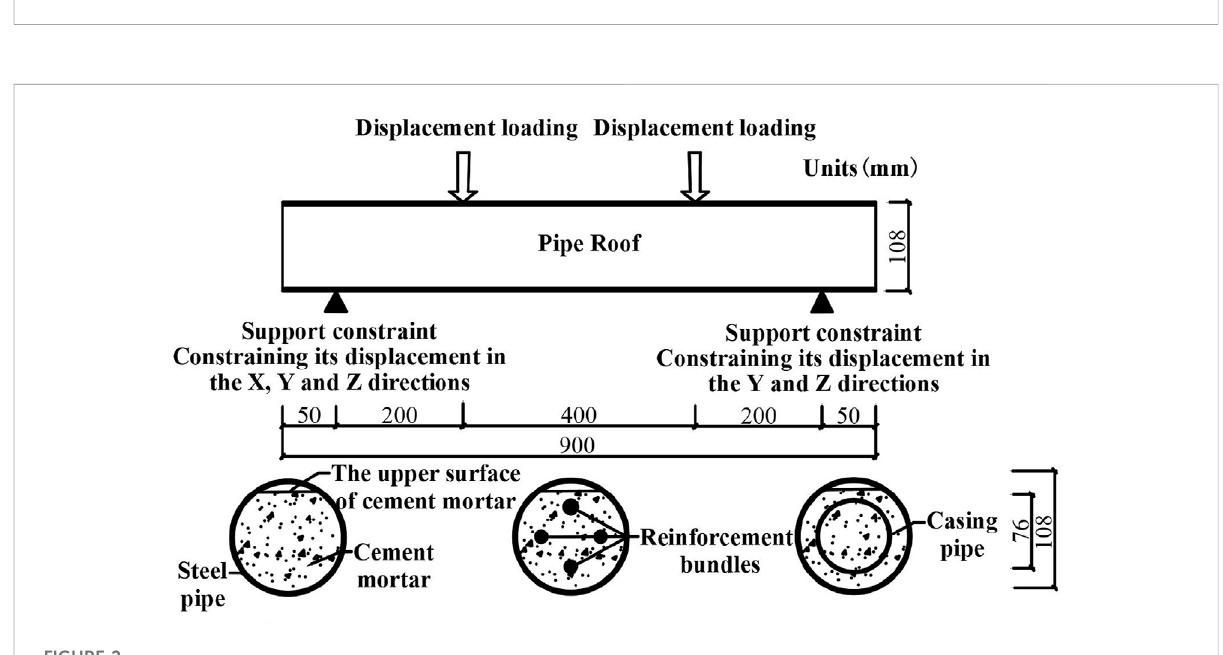
FIGURE 2 Model size and section diagram of three types of pipe roof.